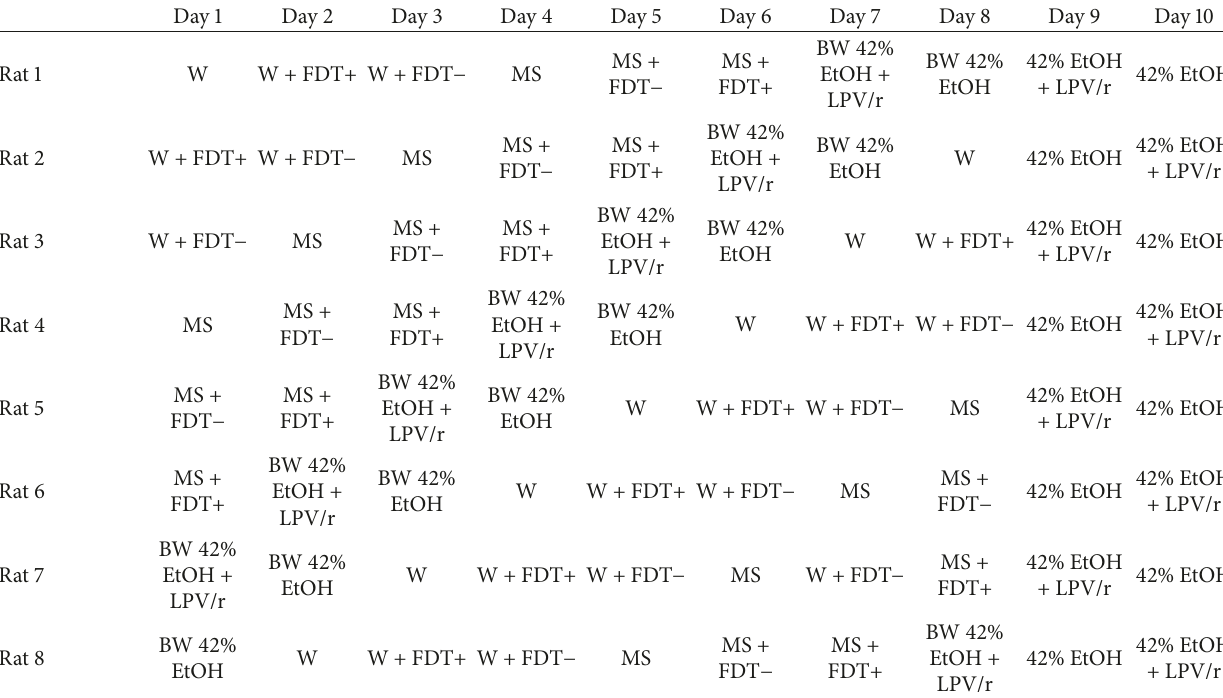
Table 1: Schedule for the 23-h consumption test sessions of water (W) and milk (MS) alone, with placebo FDT − and with FDT+ and body- weight-adjusted (BW) and full-strength 42% ethanol (EtOH) with and without LPV/r.